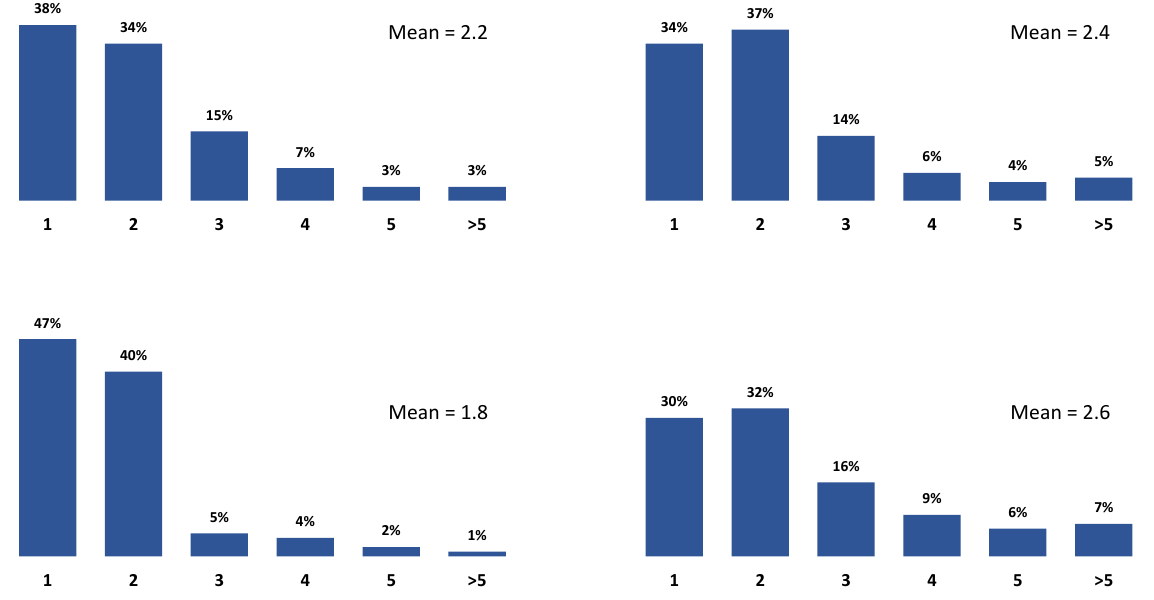
Figure 10: Distribution of the number of authors on articles by rank and year. Shown are new assistant professors (1991–1993; top left), new assistant professors (2015–2017; top right), new associate professors (1991–1993; bottom left), and new associate professors (2015–2017; bottom right).